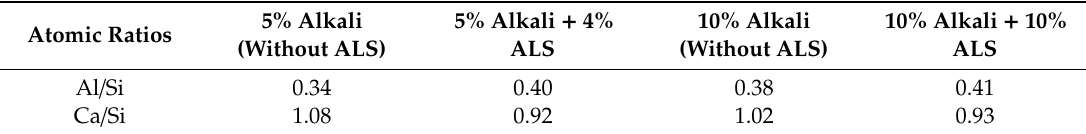
Table 5. Component ratios of hydration